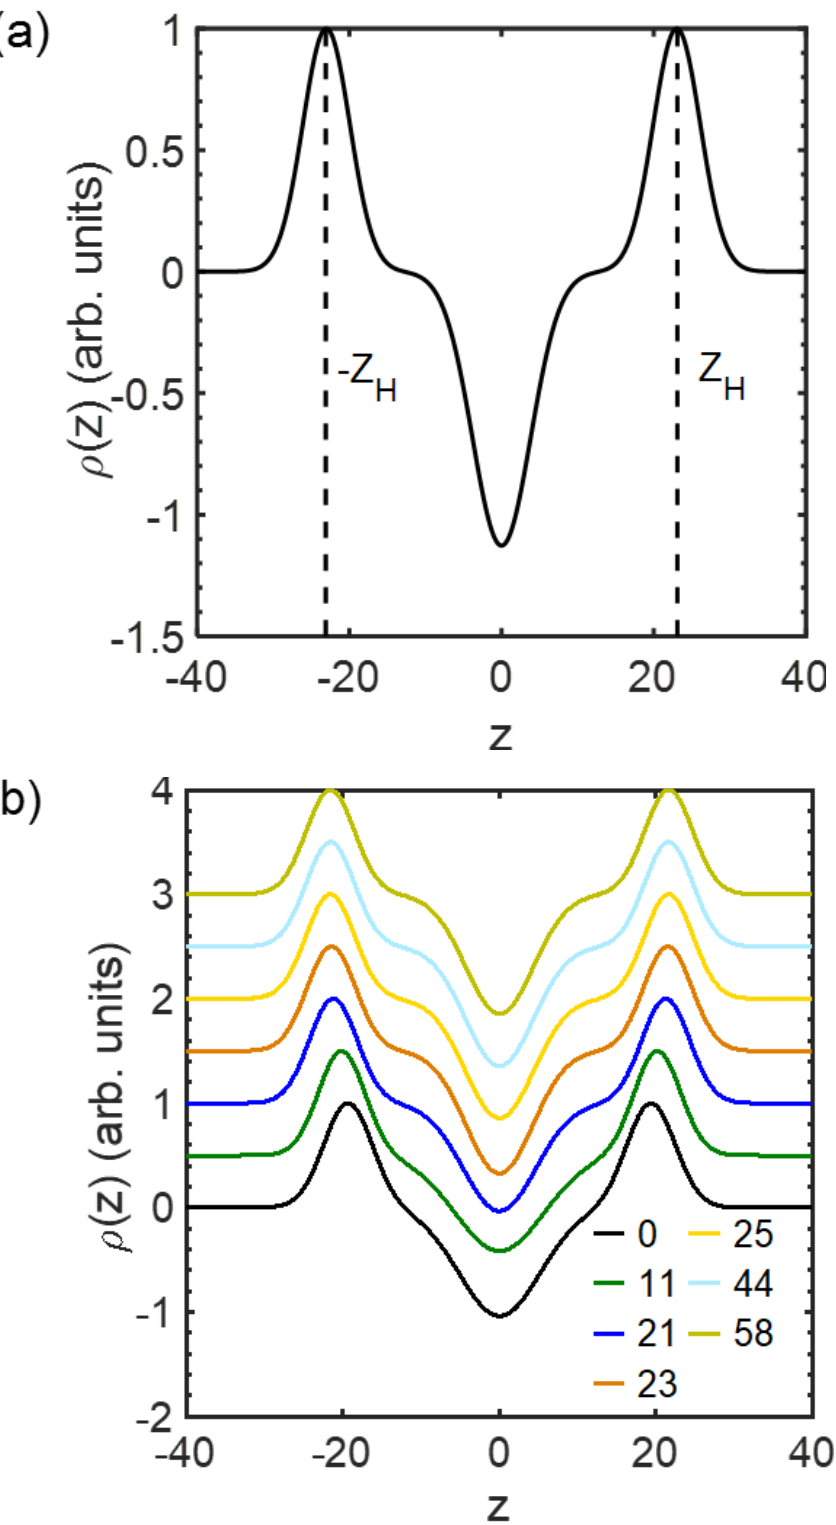
Figure 3. Electron density profile p ( z ) transverse a lipid membrane extracted from the fit against Equations (2) − (4) in Figure 2 for ( a ) the composition of DOPC/DSPC/Chol = 14/44/42 and ( b ) all the compositions for homogeneous membranes at 23 ◦ C. z H marks the position of the headgroups, and 2 z H is defined as the membrane thickness. Curves in ( b ) are vertically shifted for clarity.